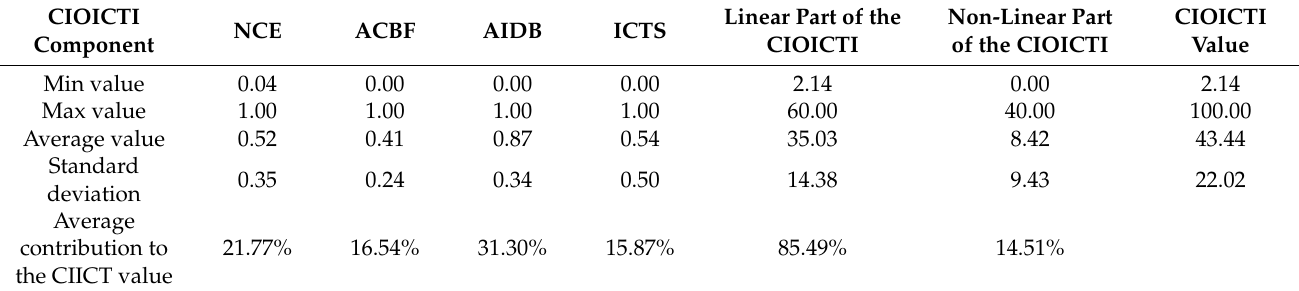
Table 10. Summary statistics for the